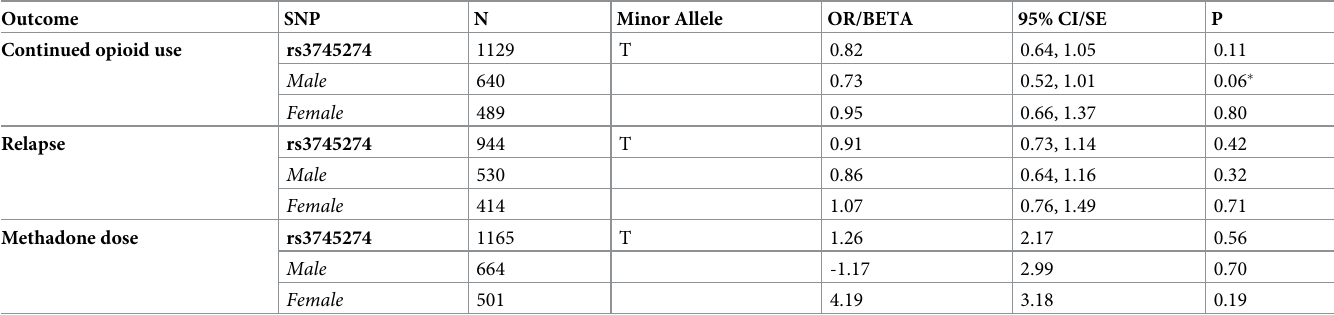
Table 4. CYP2B6 SNPs and associated